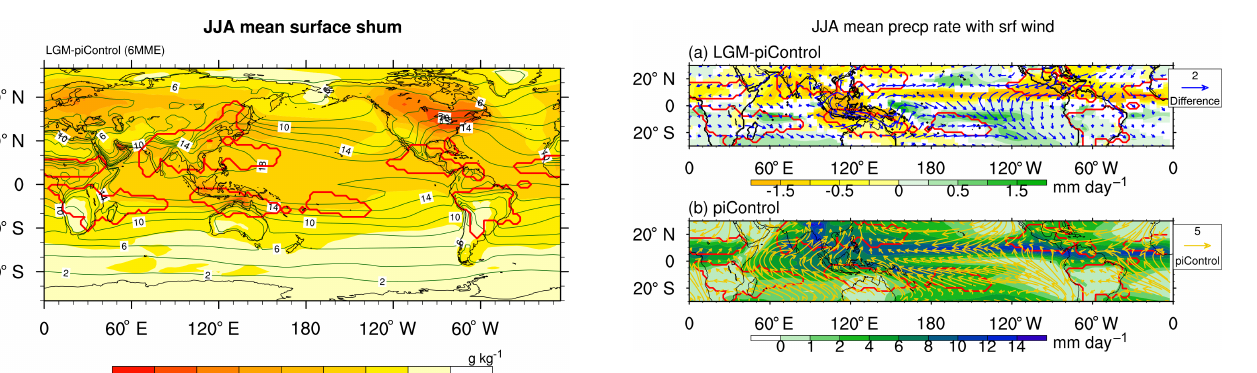
Figure 3. (a) JJA mean precipitation (shading) difference and sur- face wind (vectors) difference between LGME and piControl, and (b) the climatology of JJA mean precipitation (shading) and surface wind (vectors) derived from piControl. The red lines enclose the monsoon domains. The thick black lines in (a) denote the coastal lines in LGME provided by CMIP5–PMIP3, and the thin black lines denote the coastal lines in piControl. Only those areas where the signal-to-noise ratio exceeds 1 are plotted in (a) .